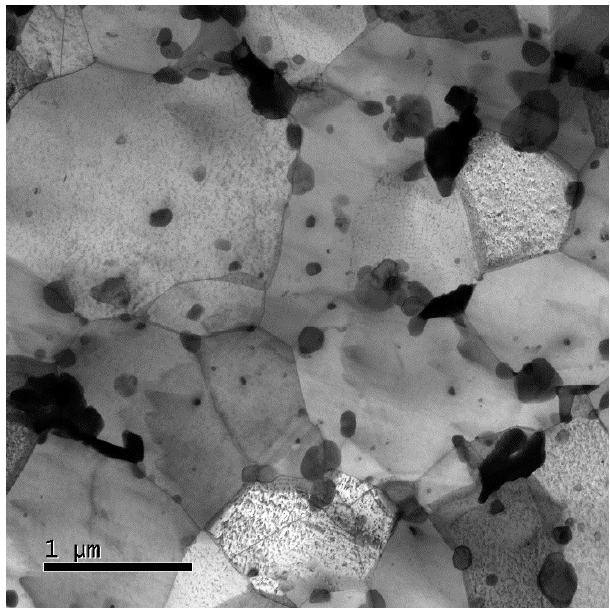
Figure 5. Microstructure of P92 steel processed by HPT and annealed at 923 K for 500 h.